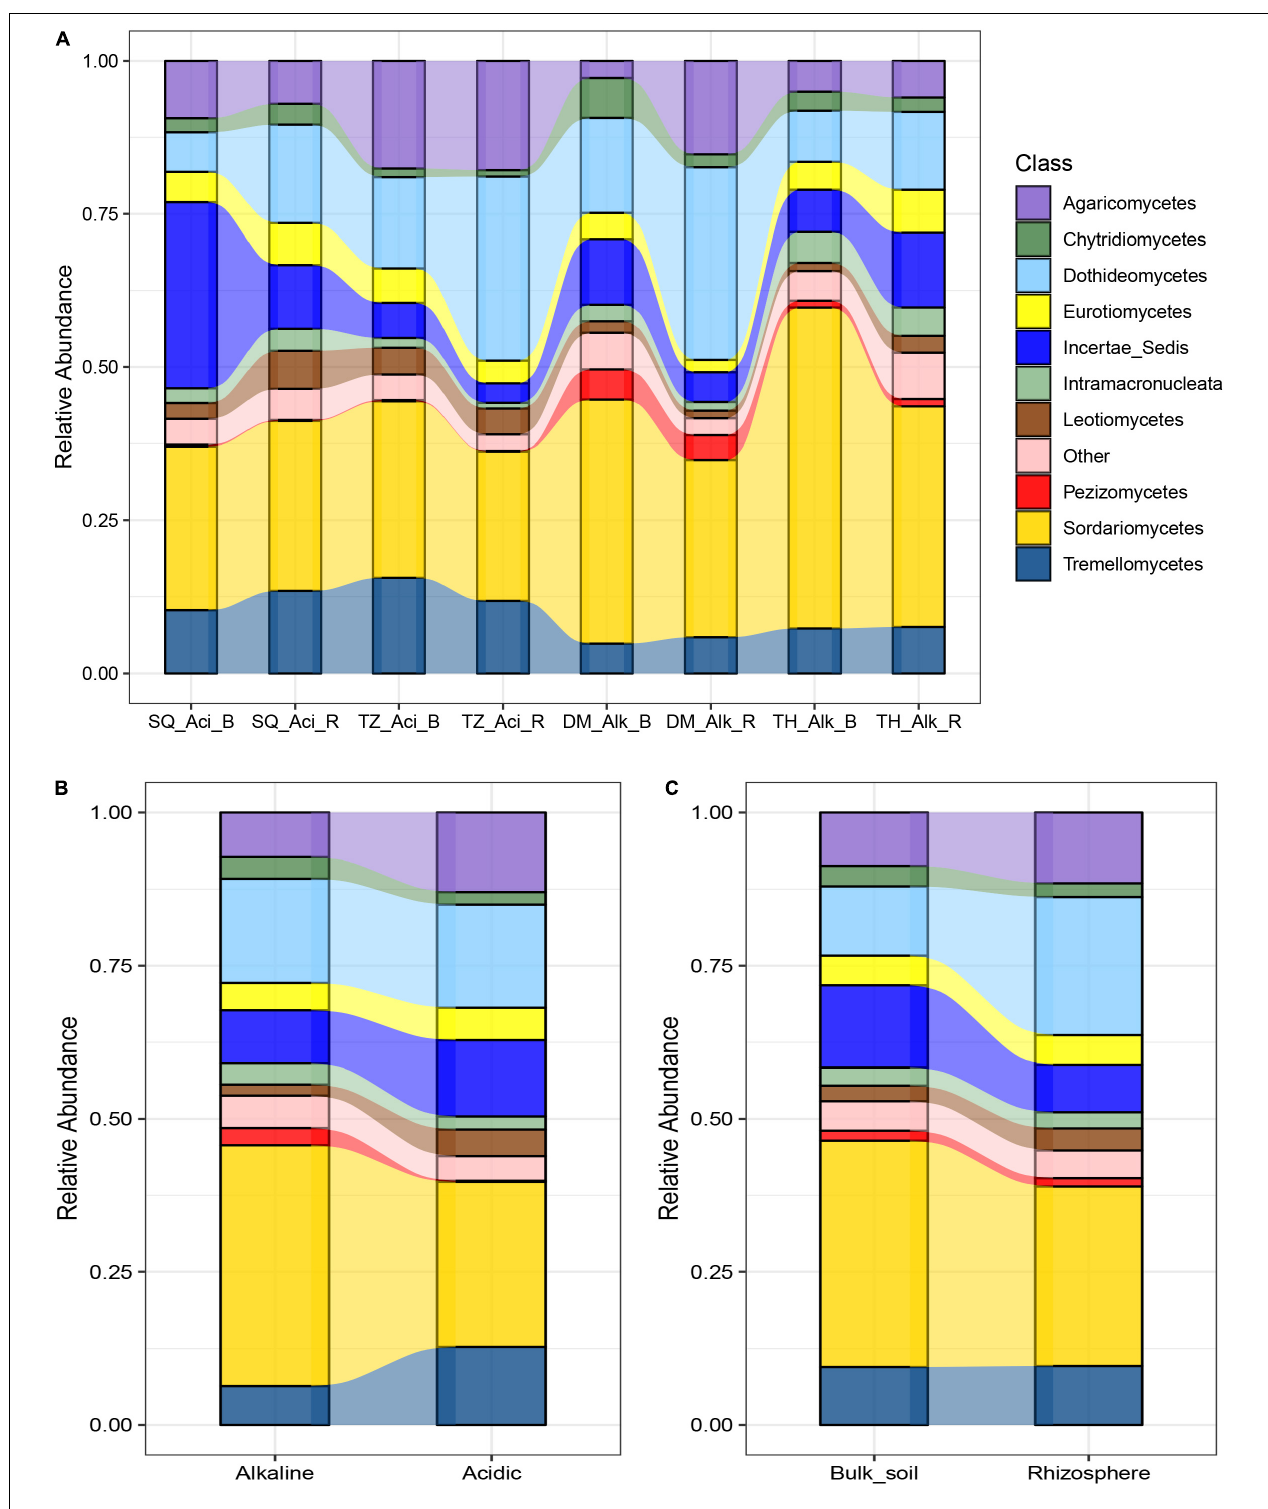
FIGURE 1 | Relative abundance of the dominant soil microeukaryotic groups in alkaline (Alk), acidic (Aci), bulk (B), and rhizosphere (R) soils from four sites in the North China Plain (Daming [DM], Sheqi [SQ], Taihe [TH], and Tengzhou [TZ]). The relative abundances of the different groups are compared across (A) site, soil type (alkaline or acidic) and niche environment (rhizosphere or Bulk soil), (B) soil type, and (C) niche environment. The relative abundances are based on the frequencies of DNA sequences that could be classified to the class level. “Other” represents sequences that were unclassified and sequences that were present in amounts of less than 1% of the